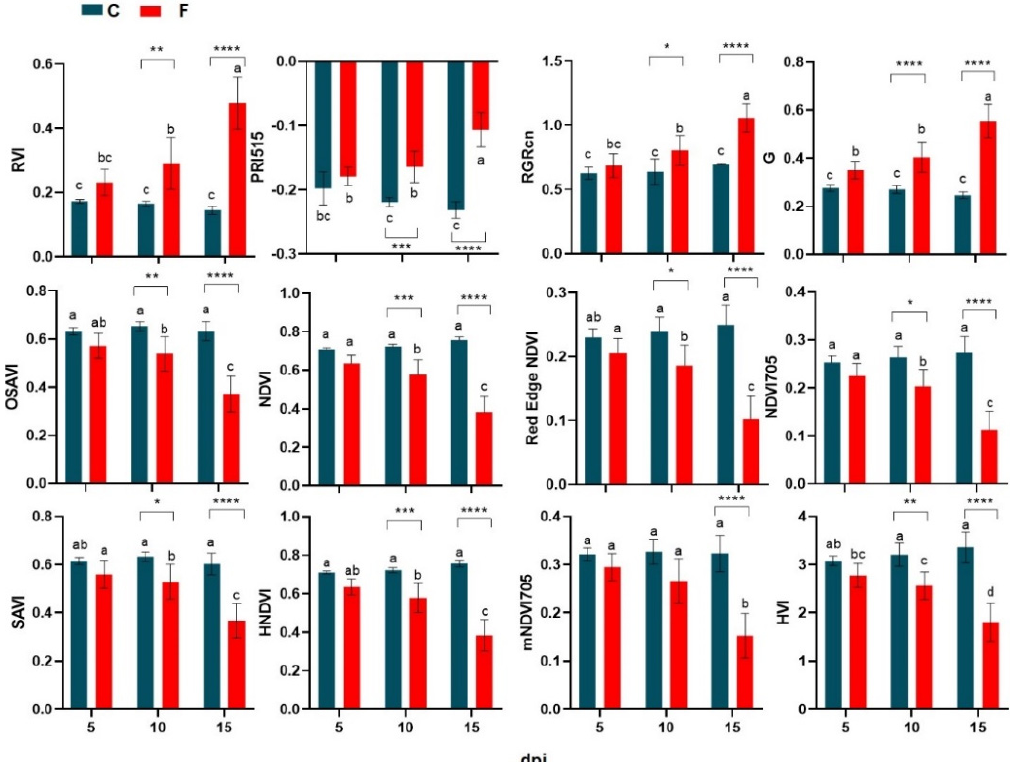
Figure 6. Average of the selected literature hyperspectral vegetation indices calculated on the canopy reflectance data from FOR-infected (F, red) and control healthy (C, dark blue) wild rocket plants at 5, 10, and 15 dpi. Bars with different lowercase letters are significantly different ( p -value ≤ 0.05) and asterisks indicate the significance level (* p -value ≤ 0.05; ** p -value ≤ 0.01; *** p -value ≤ 0.001; **** p -value ≤ 0.0001) of the pairwise comparisons between indices of FOR-infected and control healthy plants. Analyses were conducted applying ANOVA and Bonferroni correction test for multiple comparisons.